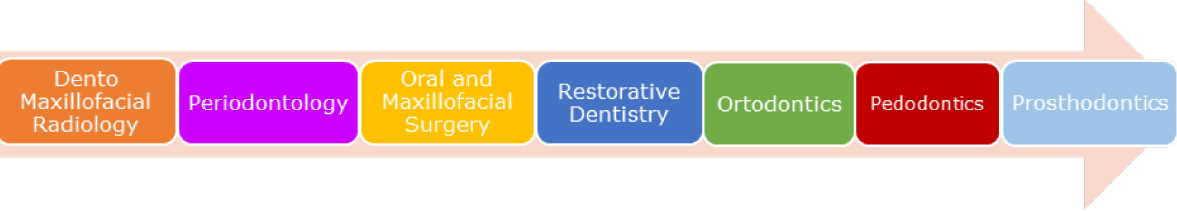
Figure 1. The real system clinics treatment